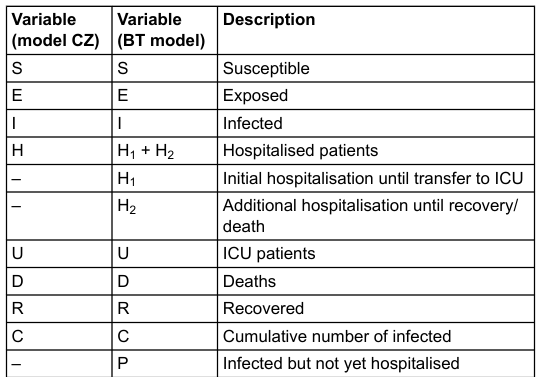
Table 2: Variables in model CZ and model BT (epidemic compart- ments).